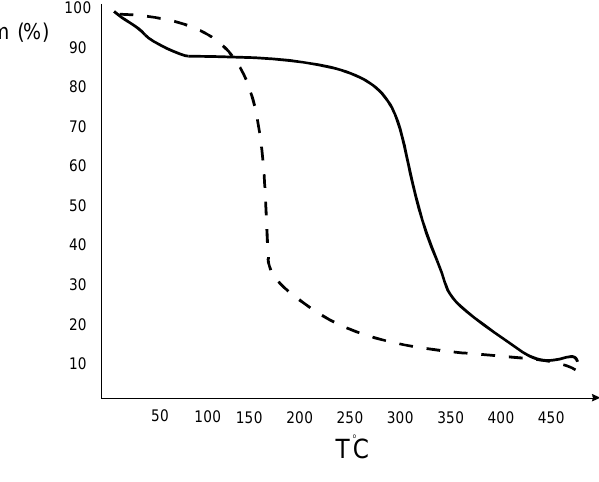
Figure 2. TGA curves for --- methoprene / BCD mixture and — methoprene /BCD